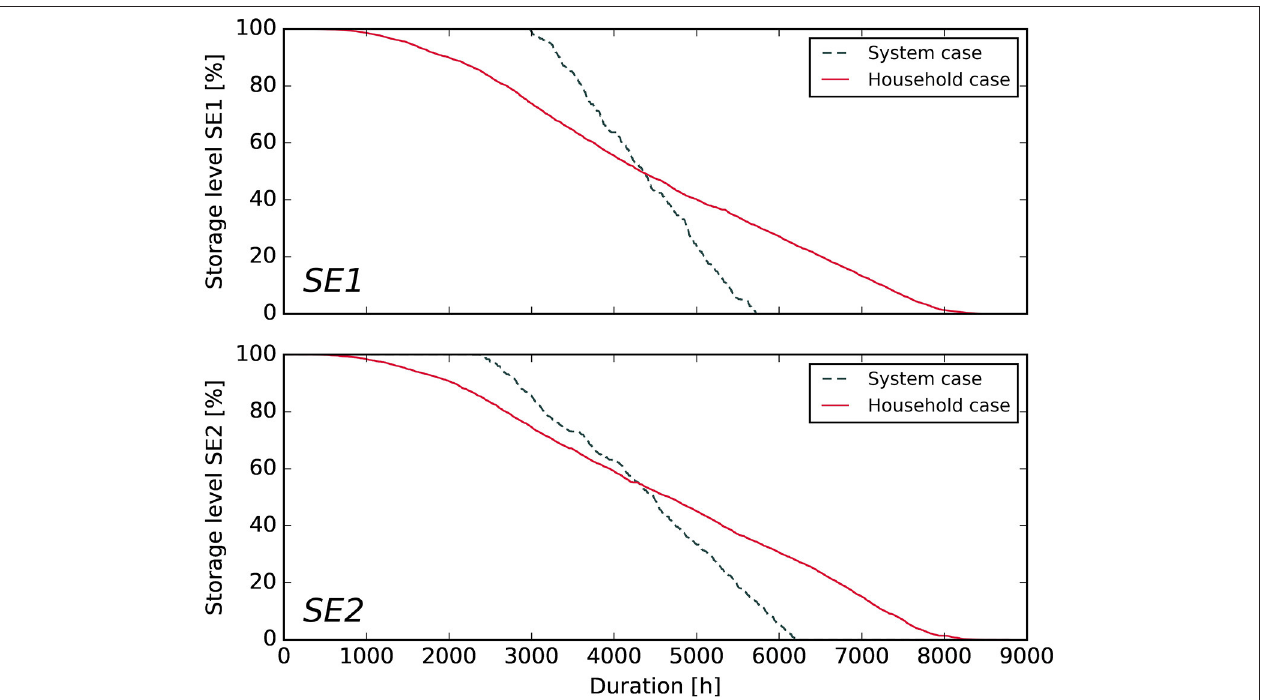
FIGURE 6 | Duration curve for the battery storage levels in the price areas SE1 and SE2 for the System and Household cases, as obtained from the modeling of the Green Policy scenario in Year 2032.